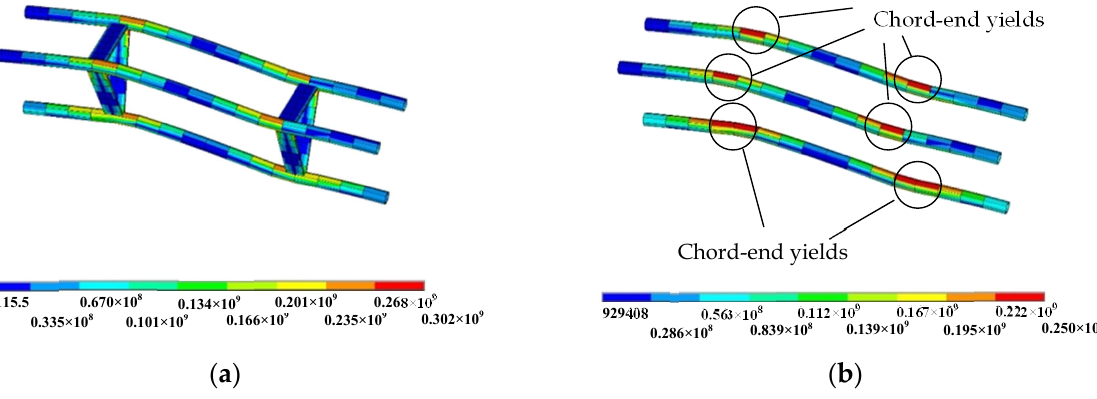
Figure 34. Stress distribution during chord local failure (HSUVL): ( a ) global stress distribution at point A(Pa); ( b ) chord stress distribution at point A(Pa).